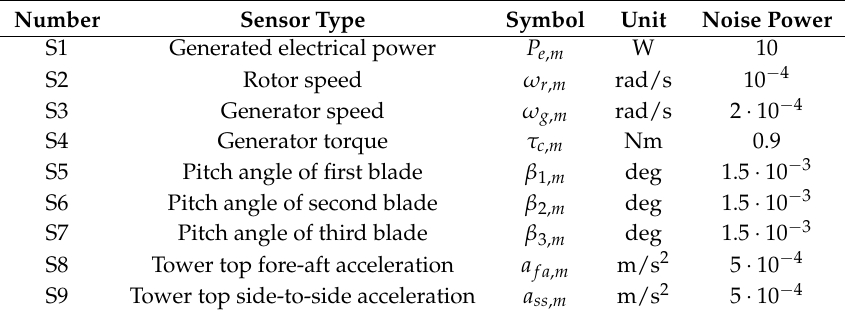
Table 1. Available sensors (measured